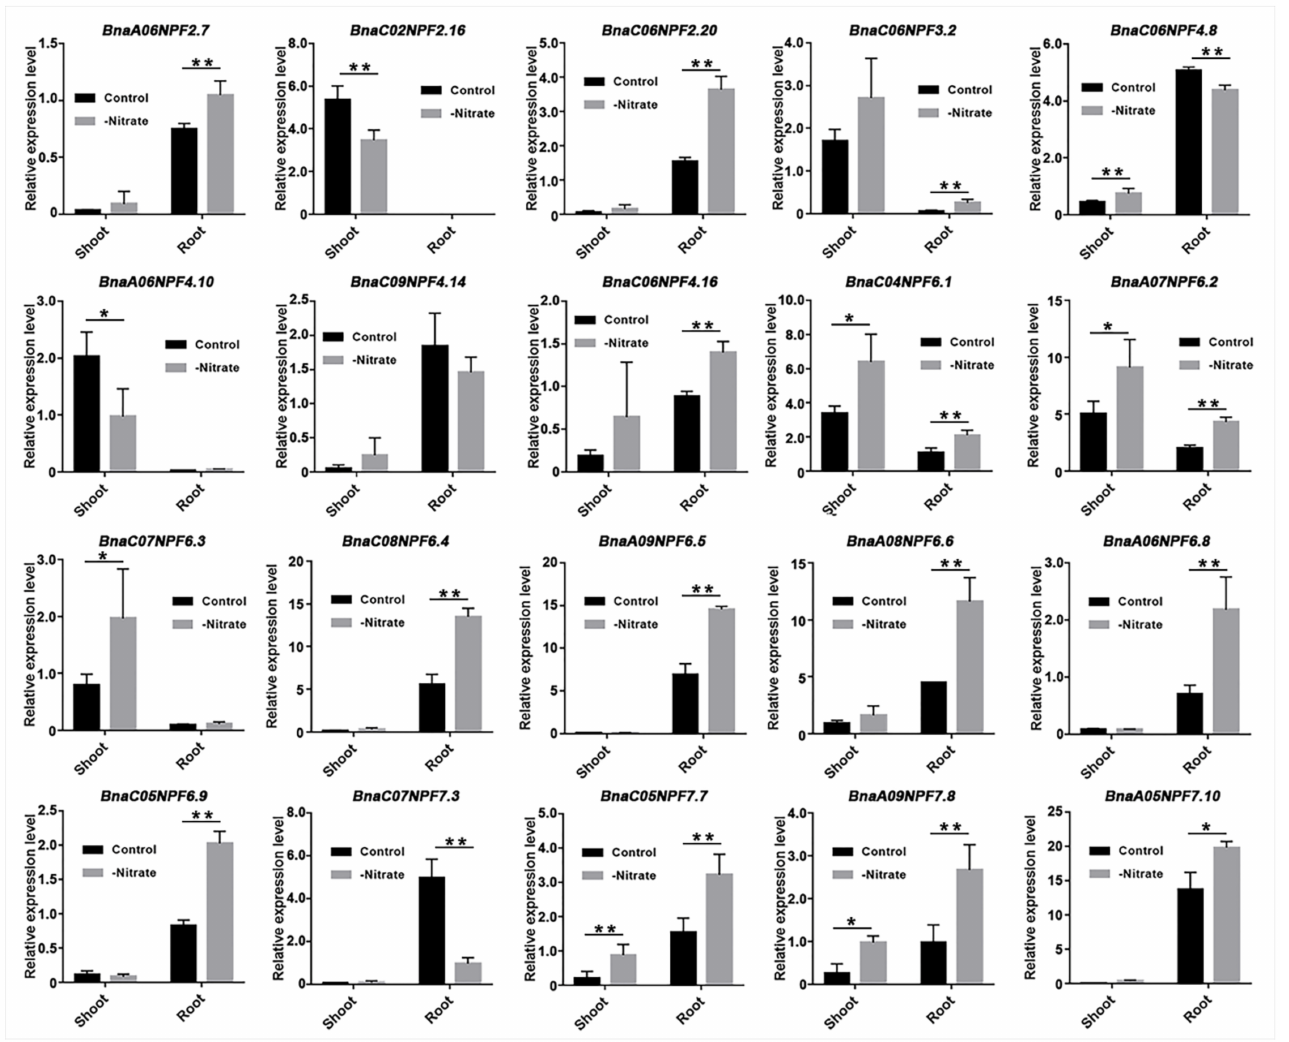
Figure 6. The expression changes detected for 20 BnaNPF genes under the condition of nitrogen suitability and deficiency. “Control” and “-Nitrate” represent treatments under nitrogen suitability and deficiency, respectively. “*”and “**” represent the significance level of 0.05 and 0.01,